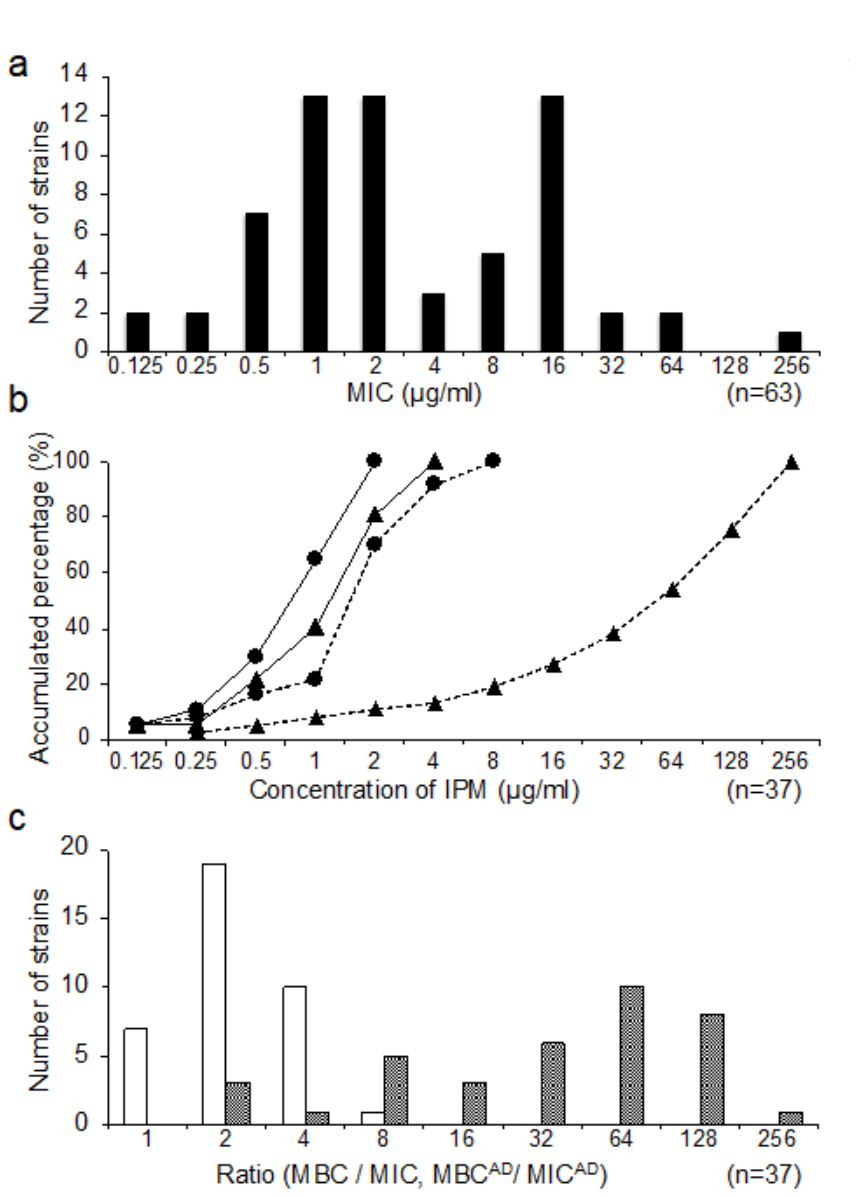
Figure 2. The MIC distribution for Imipenem of Pseudomonas aeruginosa clinical isolates from the respiratory apparatus samples ( n = 63) ( a ). Accumulated percentage of MIC, MBC, MIC AD , and MBC AD for IPM in the sensitive isolates ( n = 37) ( b ). MIC (circles on the solid line), MBC (circles on the dotted line), MIC AD (triangles on the solid line), and MBC AD (triangles on the dotted line). The ratio distribution of planktonic bacteria (MBC / MIC) and adherent bacteria (MBC AD / MIC AD ) in IPM-sensitive isolates ( n = 37) are shown ( c ). The white bars represent the number of strains of MBC / MIC in planktonic bacteria, and the black bars represent the number of strains of MBC AD / MIC AD in the adherent bacteria.